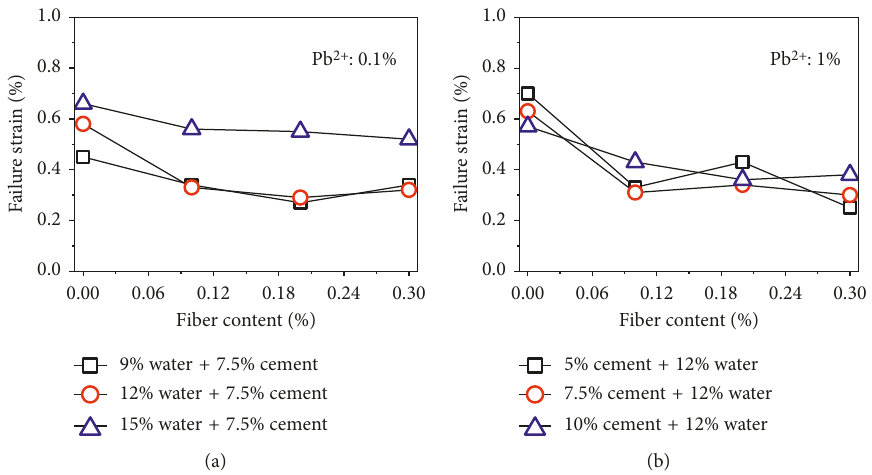
Figure 5: Failure strain of fiber-reinforced soil samples under 9 cycles. (a) Various percentages of water content based on 7.5% cement+0.1% Pb(II). (b) Various percentages of cement content based on 12% water+1% Pb(II).